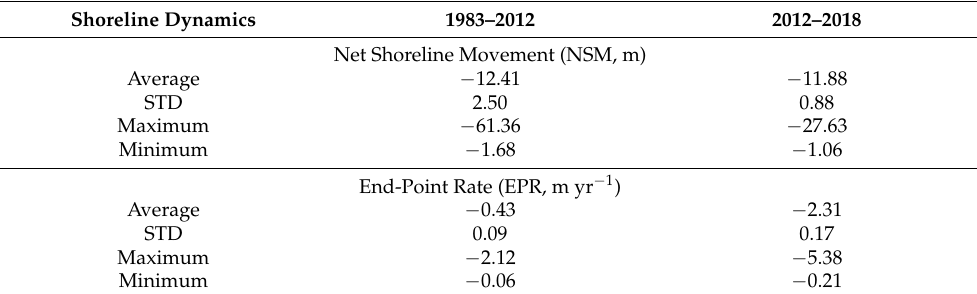
Table 2. The analysis of shoreline changes on Inexpressible Island in periods 1983–2012 and 2012– 2018. NSM represents the distance between shorelines, EPR represents the annual rate of shoreline